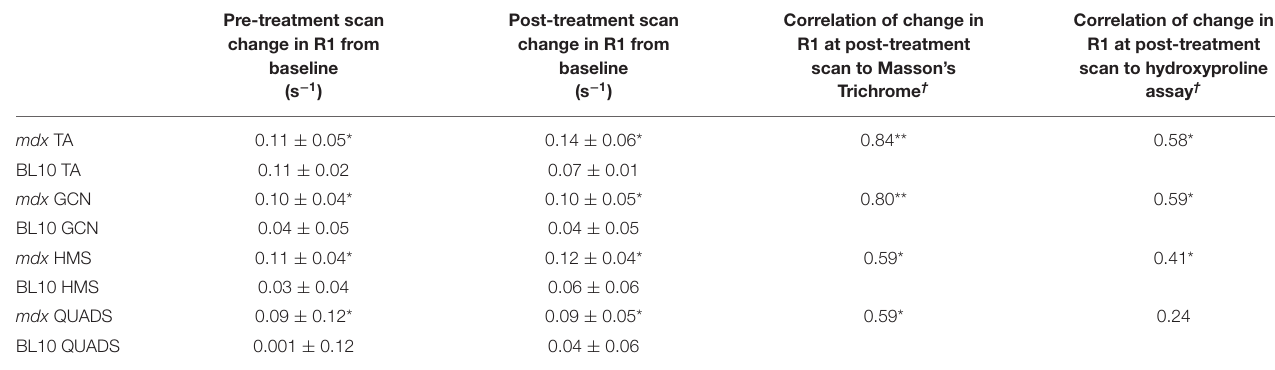
TABLE 1 | Table to show absolute R1 change at both the pre- and post-treatment scans. Pre-treatment scan change in R1 from